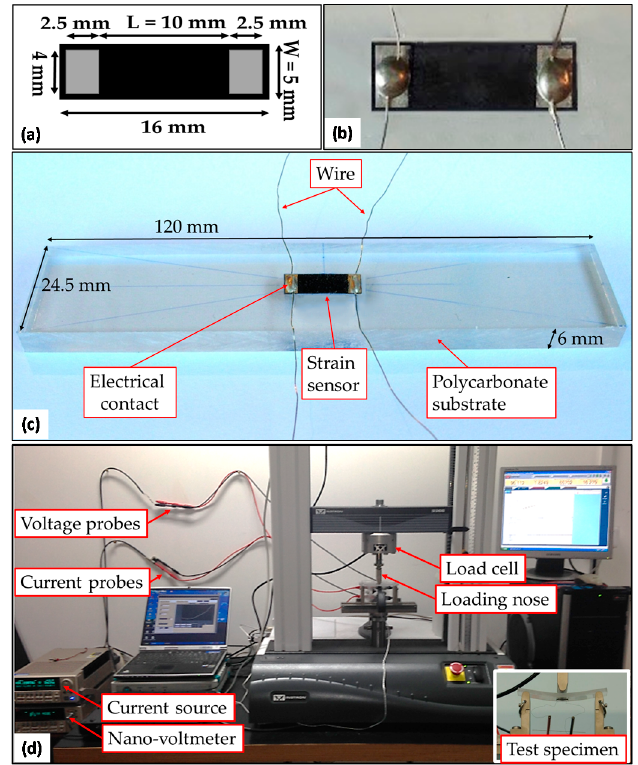
Figure 2. ( a ) Dimensions of the strain sensors with electrical contact areas; ( b ) photograph of the realized sensor; ( c ) photograph of a test bed, including a strain sensor attached over a polycarbonate beam; ( d ) electromechanical test setup, including the test bed, voltage probes, source meter, nanovoltmeter and laptop computer.